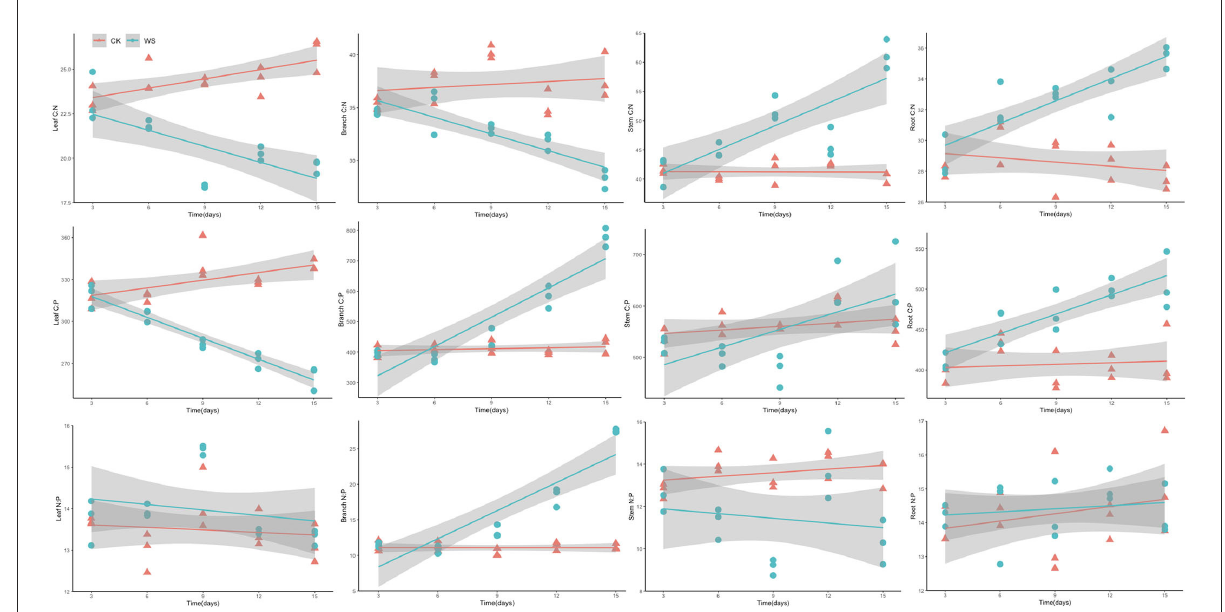
FIGURE7 Analysis of stoichiometry characterization of C, N, and P elements of P. heteroclada in the riparian zone.